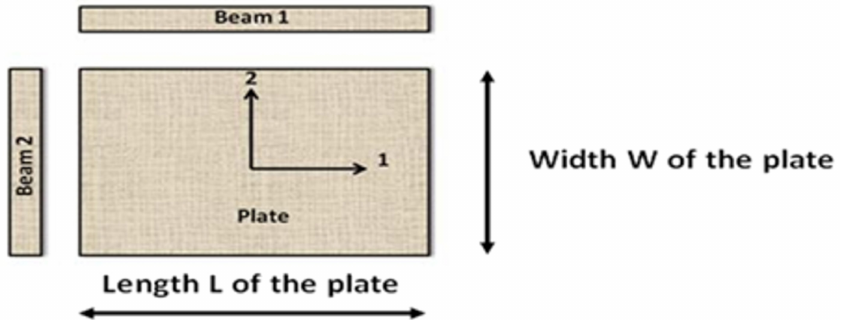
Figure 3. Two test beams cut along the two orthotropic directions, and a test plate with edges parallel to the orthotropic material directions.